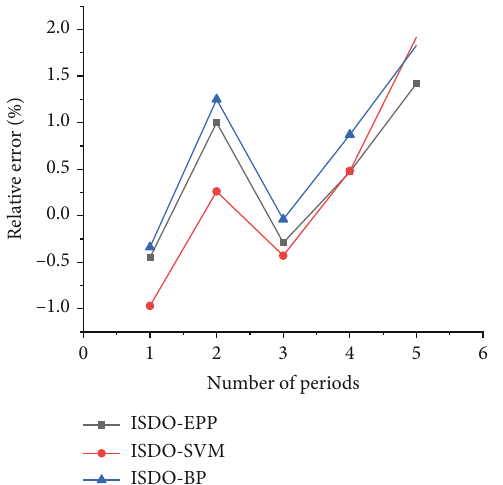
Figure 5: Relative error of three models in example 1.